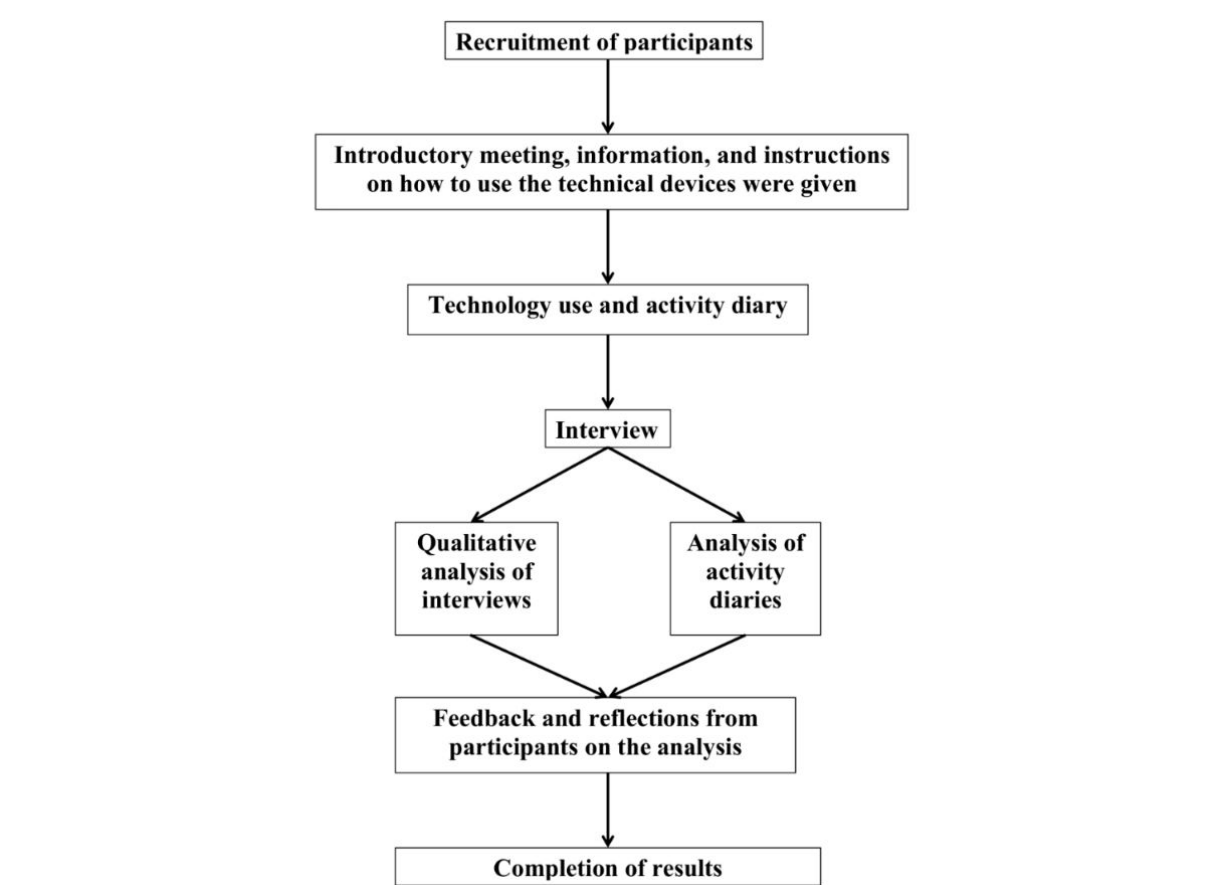
Figure 1. Overview of the applied study